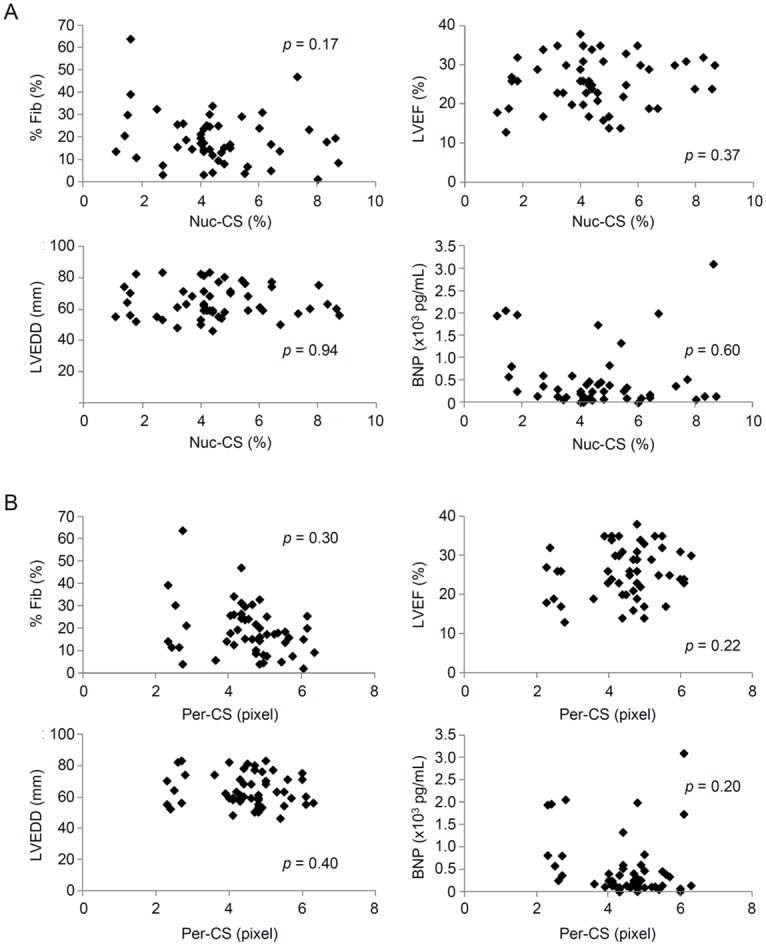
Relationship between the Nucleoplasmic Chromatin Score (Nuc-CS), Perinuclear Chromatin Score (Per-CS), and Clinical Parameters.Scatter plots of clinical parameters are shown. % Fib: area of fibrosis within the specimen, LVEF: left ventricular ejection fraction, LVEDD: left ventricular end-diastolic diameter, BNP: brain natriuretic peptide. p: correlation coefficient.